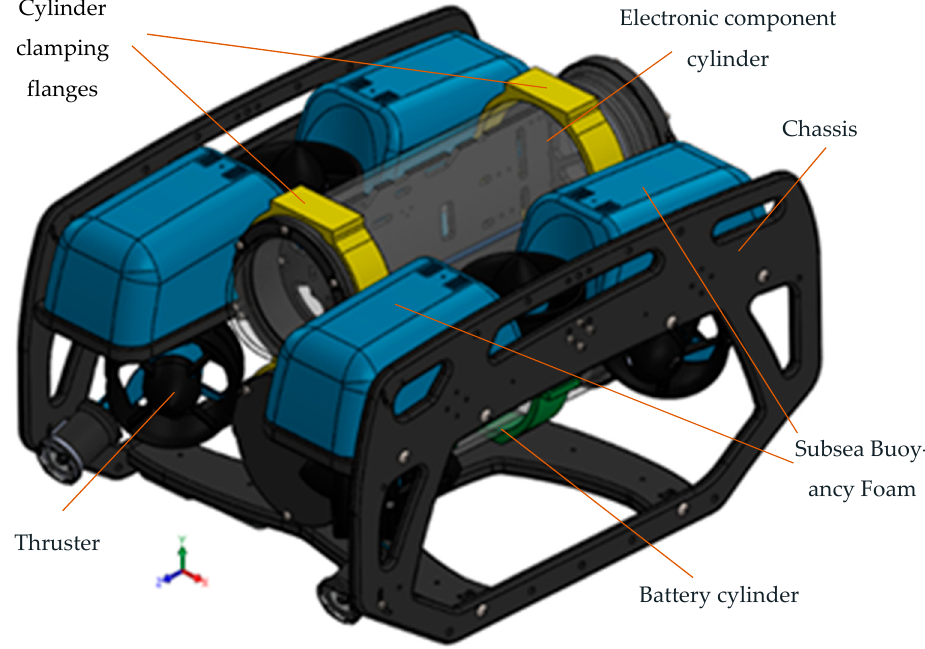
Figure 1. ROV used for recognition and rescue missions.